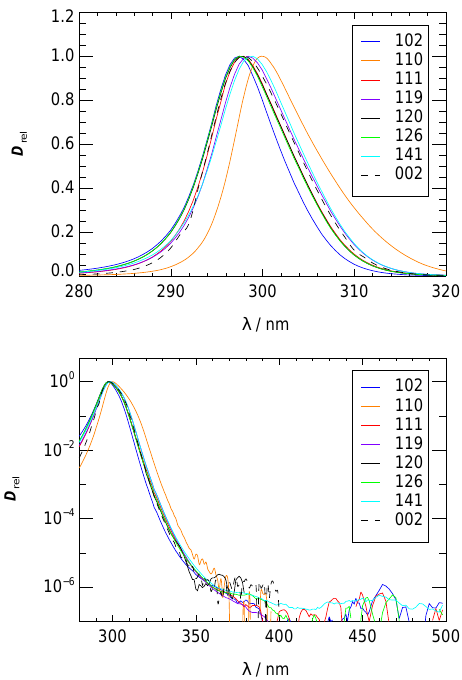
Figure 4. Relative spectral sensitivities D rel as in Fig. 3 after ex- change of interference filters: peaks are slightly broader (upper panel), and sensitivities above 350nm now range around 10 − 6 or less because of better blockings (lower panel). For FR 110 an in- terference filter of a different batch was employed (see text). The dashed curve shows the spectral sensitivity of FR 002 from a previ- ous study (Bohn et al.,